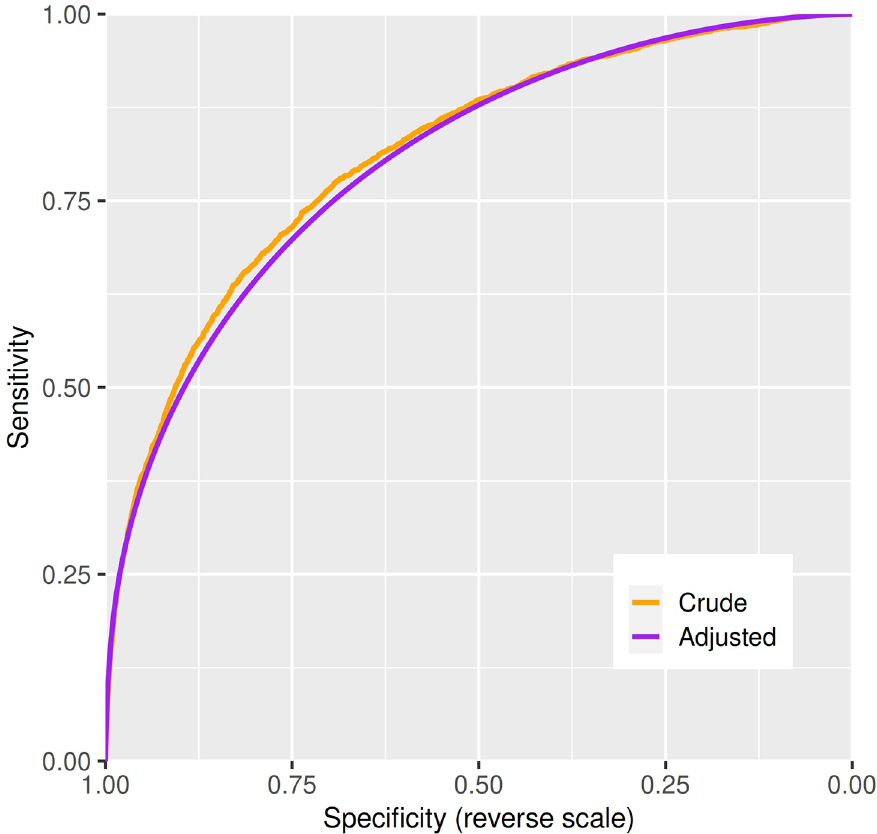
Fig 3. Cross-validation of model chosen by stepwise regression using extended variable set: ROC curve. The ROC curve is computed by calculating at each value of the risk score the sensitivity and specificity of a classifier that uses this value as the threshold for classifying cases and noncases. Using the adjusted distributions from Fig 2 gives a curve that is concave downwards. The C-statistic is the area under this curve, computed as the probability of correctly classifying a case/noncase pair using the risk score, evaluated over all possible such pairs in the dataset. ROC, receiver operator